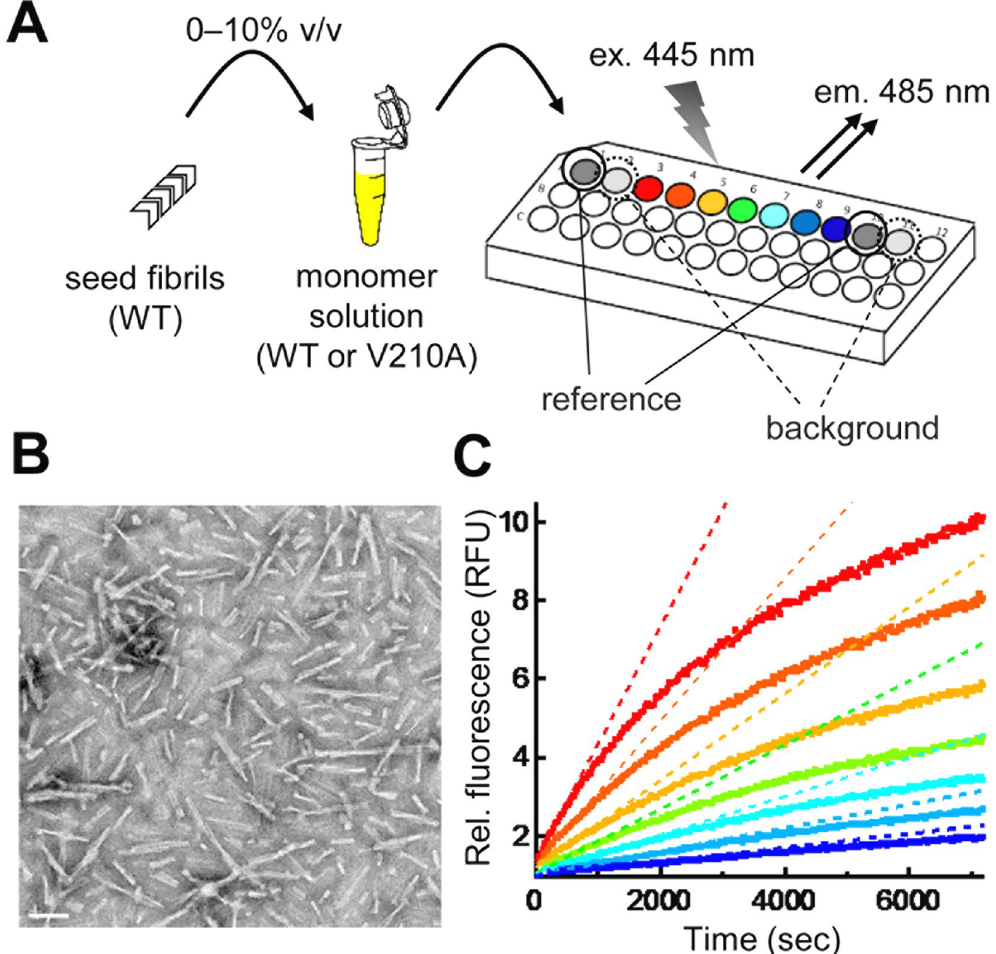
Figure 1. ( A ) A schematic representation of seeded growth experiments. ( B ) Transmission electron microscopy images of seed fibrils (scale bar, 100 nm). ( C ) A representative result of the seeded growth experiment. The growth reaction was examined at a fixed concentration of seed fibrils (2.5%) and GuHCl (3.0 M) by varying the monomer concentration from 5 to 300 µ M (from bottom to top). The dotted lines represent the linear fits to the initial increase in